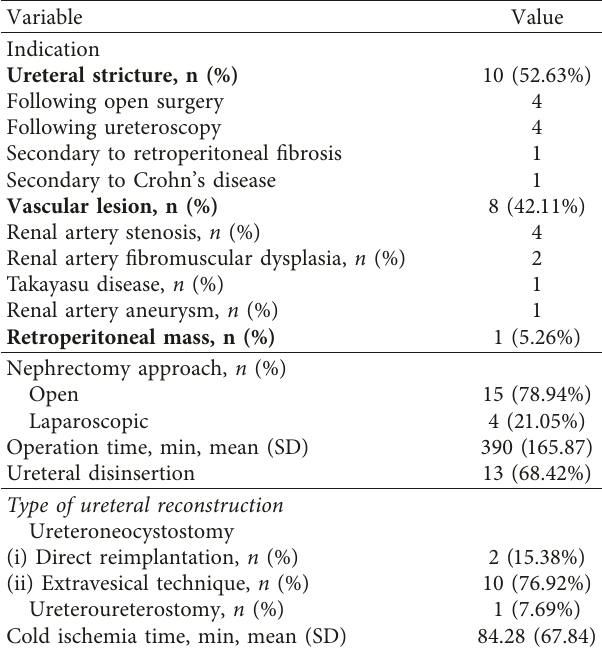
Table 7: Indications of KATs and surgical